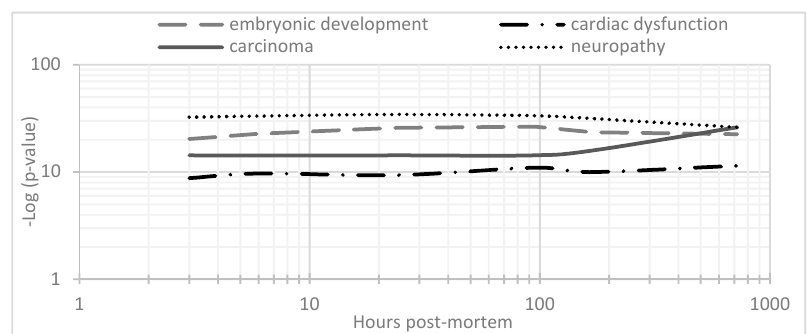
Figure 2. Hierarchical clustering using z-scores of protein abundance across PM time scales. ( A ) Hierarchical clustering based on Z-score normalised log2-transformed intensities show the biological replicates of each PM time point cluster together. The greatest difference was observed between 24 to 96 h and 720 h PM. Increases in protein abundance levels (red) and decreases (green) can be demonstrated across PM time with black indicating no change. Groups of proteins are seen to modulate together. These correlate to ( B ) enriched canonical protein networks and are better visualised at the functional level based on changes in z-scores normalised to 1 h-time points. The corresponding enriched pathologies are provided in ( C ) based on p -values of enriched protein pathways triggered through PM time. These pathologies are commonly observed in the study of many living systems.